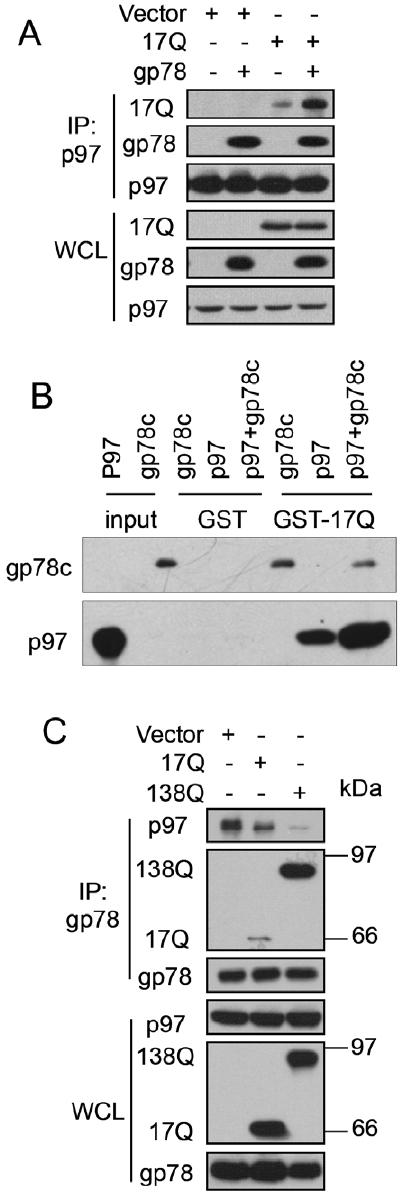
Figure 3. gp78 forms a complex with Nhtt and p97/VCP and Nhtt138Q disrupts gp78-p97/VCP interaction. A. gp78 enhances Nhtt17Q interaction with p97/VCP. HEK293 cells transfected as indicated were processed for IP for p97/VCP. Immunoprecipitates were blotted for the indicated proteins. B. Formation of trimeric complex of GST-Nhtt17Q, gp78c, and p97/VCP. GST-Nhtt17Q immobilized on beads was incubated with purified 6-His-p97/VCP and 6-His-gp78c. After washing, GST-Nhtt17Q-associated gp78c and p97/VCP were detected by immunoblotting. C. Nhtt inhibits gp78 interaction with p97/VCP and polyglutamine expansion aggravates the inhibition. HEK293 cells transfected as indicated were processed for immunoprecipitation for gp78. Precipitates were blotted for the indicated proteins.